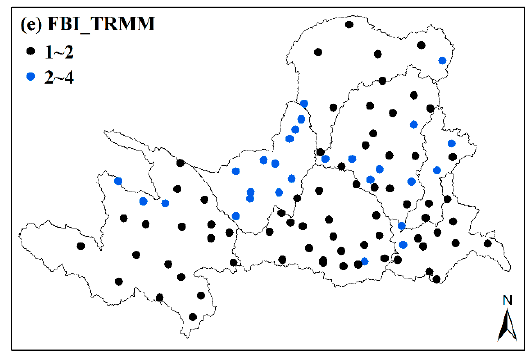
Figure 8. Spatial pattern of FBI (frequency bias index).